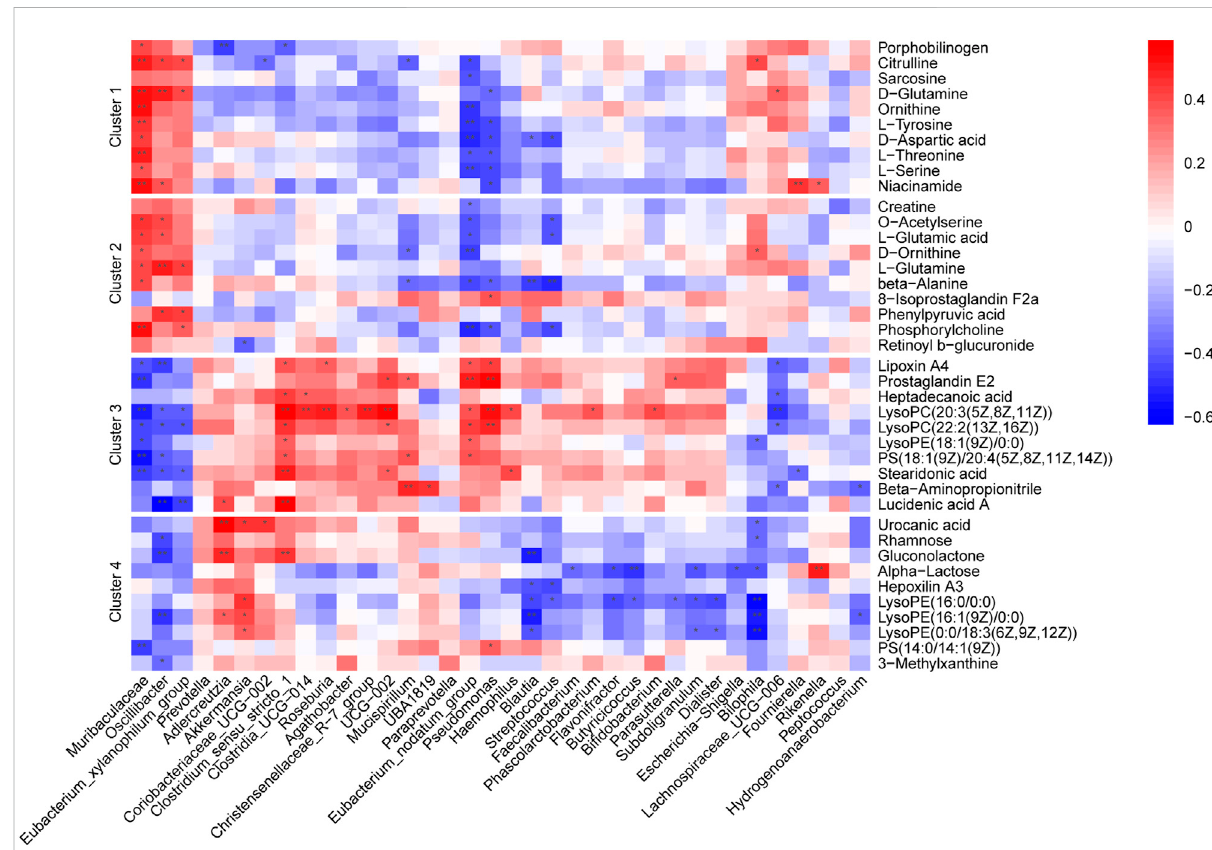
FIGURE 6 Heatmaps of Spearman correlation analysis between altered gut microbes and metabolites. Crosses show the correlation coef fi cients (r), * p < 0.05, ** p <